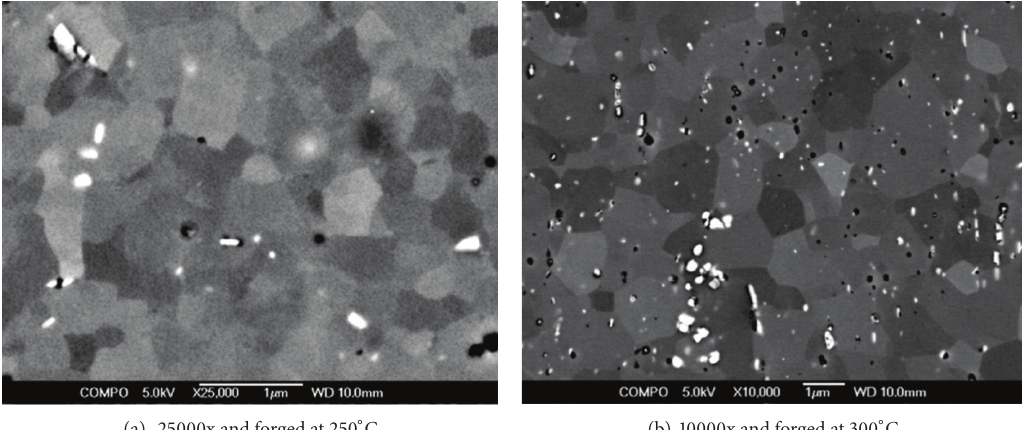
Figure 11: SEM micrographs at 10000x of zone 2 of the blade with N2 as starting